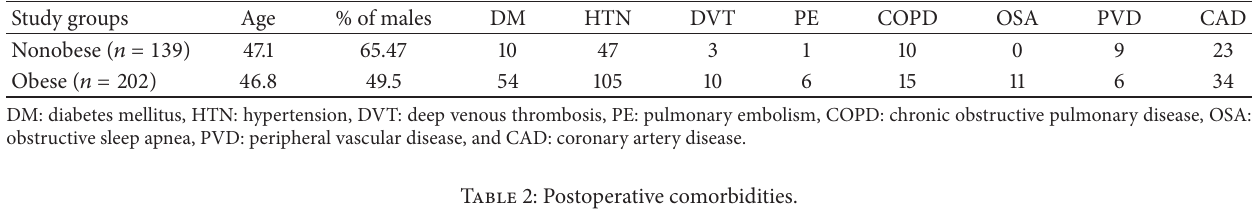
Table 1: Demographics and comorbidities.